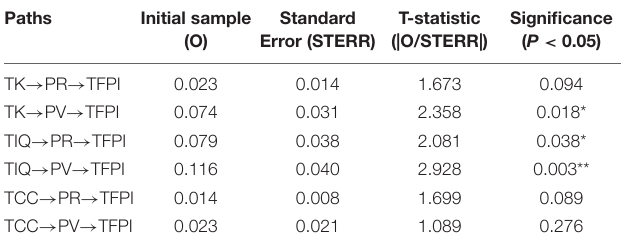
TABLE 6 | Mediating effect analysis.